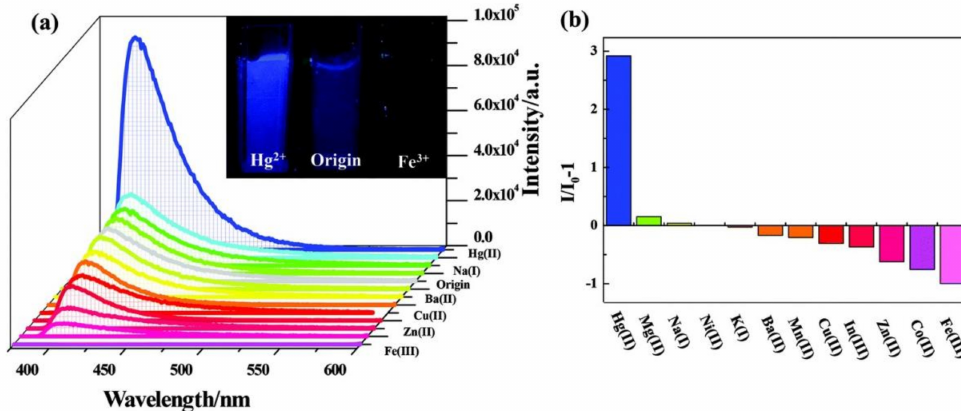
Figure 4. ( a ) Suspension-state PL spectra (inset: the images under UV-light irradiation at 365 nm) and ( b ) the relative intensities of [Ag(2,4 (cid:48) -Hpdc)(4,4 (cid:48) -bpy)] n at 401 nm dispersed in aqueous solutions containing different metal ions (50 µ M) when excited at 300 nm (reproduced with the permission from Ref